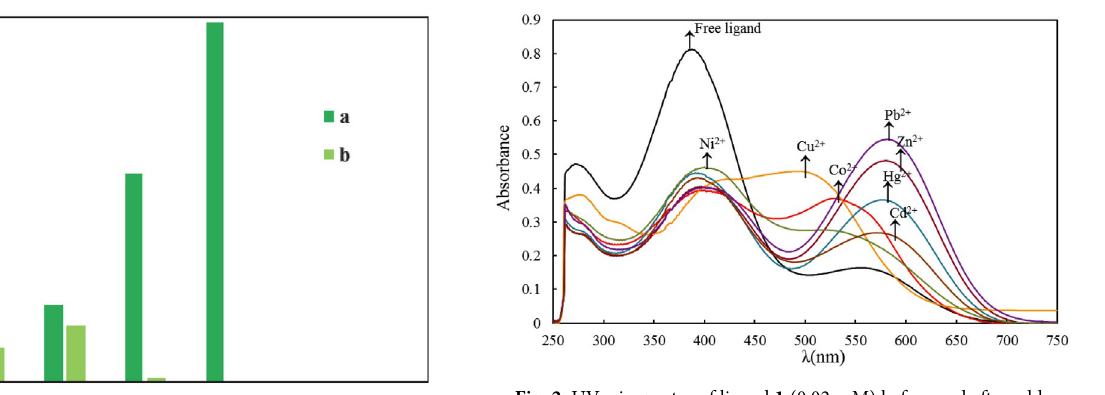
Fig. 2 . UV–vis spectra of ligand 1 (0.02 mM) before and after add- ing a 0.02 mM concentration of various metal acetates in a DMSO